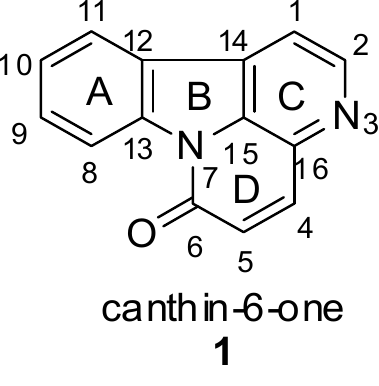
Figure 1. Structure of canthin-6-one 1 Figure 1 . Structure of canthin-6-one 1 .